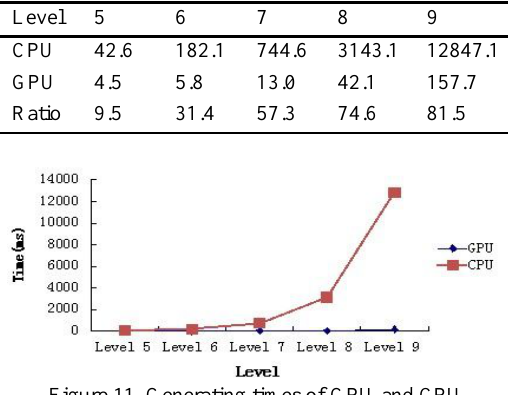
Figure 10. Generating times of the two algorithms Table 3. Generating times of GPU and CPU